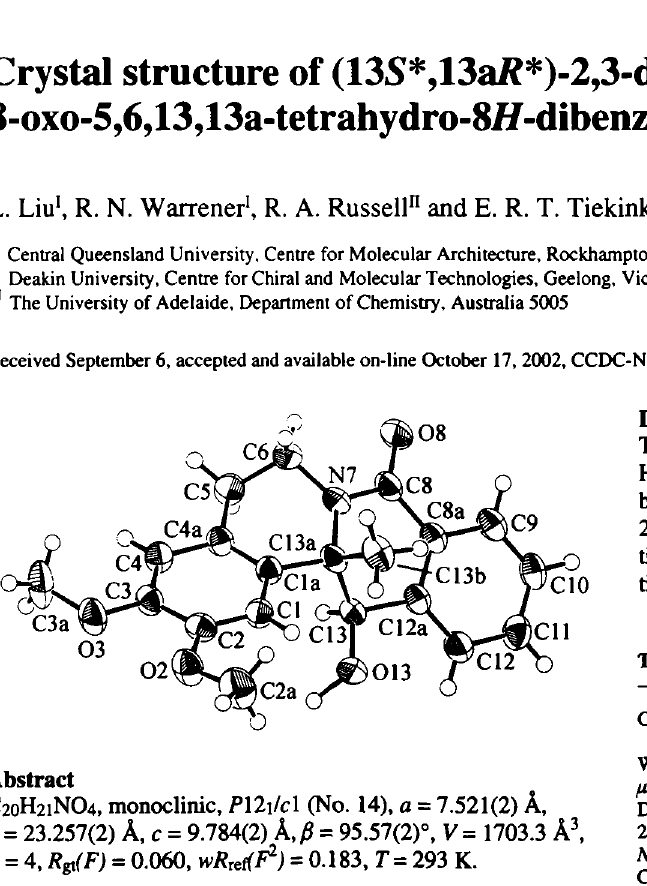
Table 2. Atomic coordinates and displacement parameters (in A 2